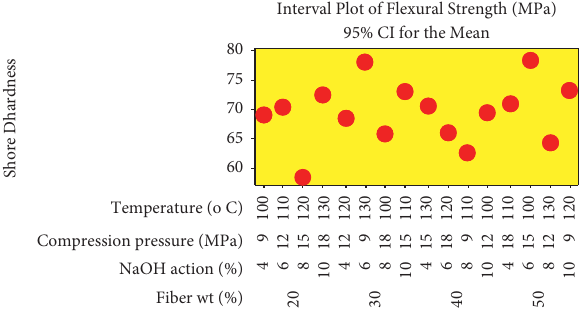
Figure 21: Interval plot of shore D hardness inspection.